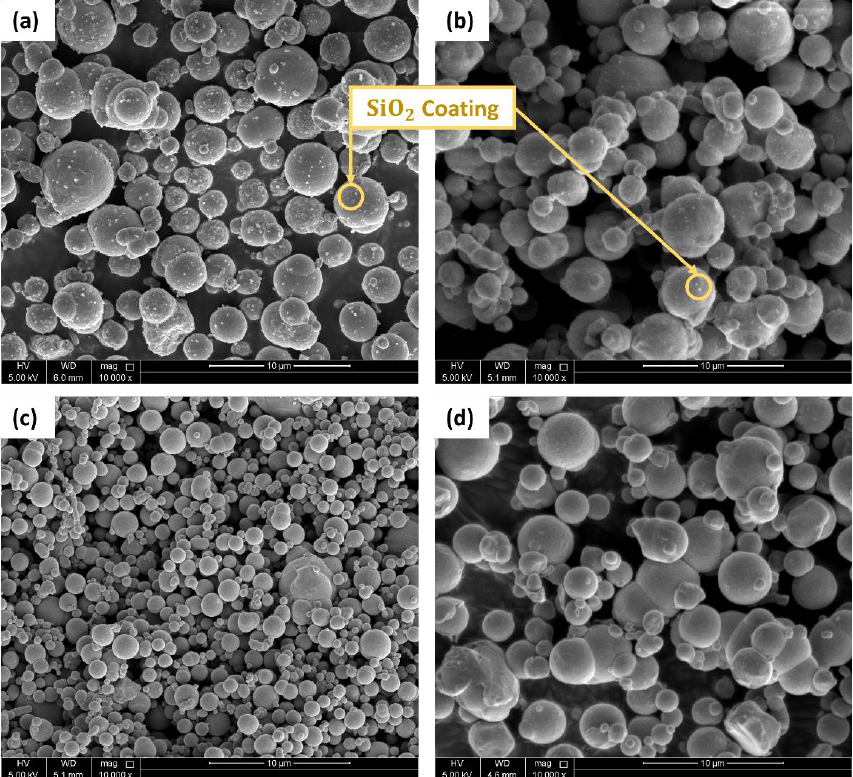
Figure 3. SEM images of the carbonyl iron particles; ( a ) type 1: H-C, ( b ) type 2: S-C, ( c ) type 3: H-NC, and ( d ) type 4: S-NC.